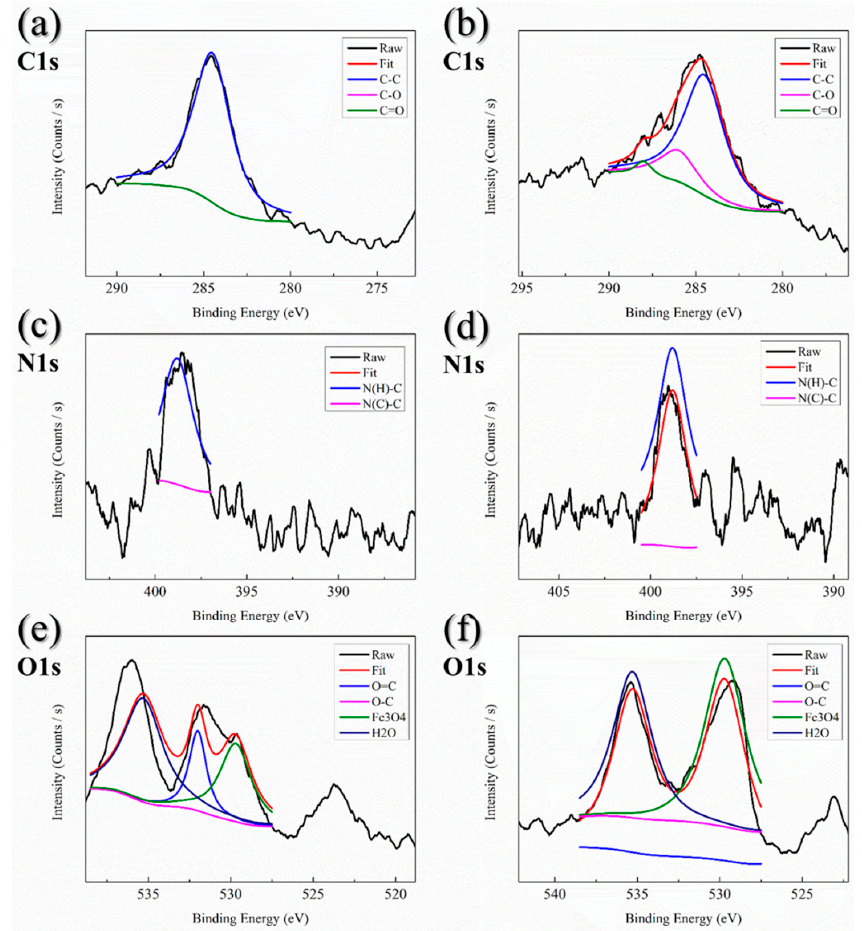
Figure 3. X-ray photoelectron spectroscopy (XPS) spectra of ( a , c , e ) MNPs and ( b , d , f ) MCP-1-motif MNPs.